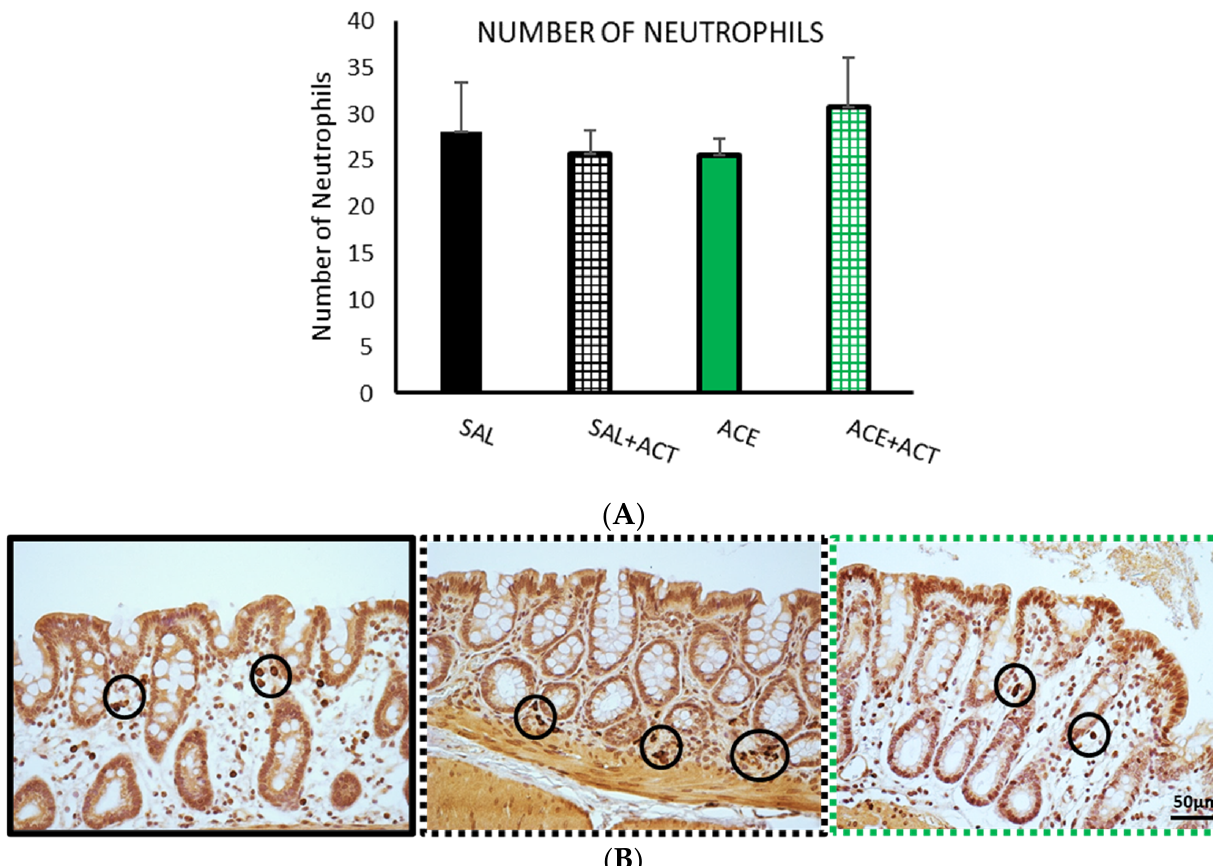
Figure 11. Effects of pretreatment with probiotics on the number of neutrophils, phase II. The groups selected in phase I (SAL30 and ACE 0.6% 30, now termed SAL, black bar and ACE, green bar) were compared with the corresponding two groups that were pretreated with 1 mL/day of Actimel ® (ACT), 7 days before performance of the visceral sensitivity test (SAL + ACT black gridded bar, ACE + ACT green gridded bar). The number of neutrophils ( A ) was assessed using immunohistochemical methods in ten random fields per section. Data represent mean ± SEM. No statically significant differences were found. One-way ANOVA followed by Bonferroni post hoc test ( n = 8–13). ( B ) Photomicrographs of myeloperoxidase immunopositive cells (neutrophils, see circles) in colonic mucosa after intracolonic administration of SAL (black frame) or in animals pretreated with Actimel ® after intracolonic administration of saline (SAL + ACT; black dotted frame) or 0.6% acetic acid (ACE + ACT) green dotted frame). Scale bar = 50 μm.